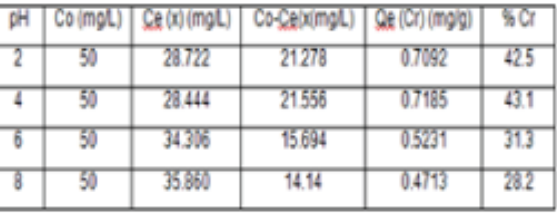
Table 2: Effect of pH on the removal of chromium from aqueous